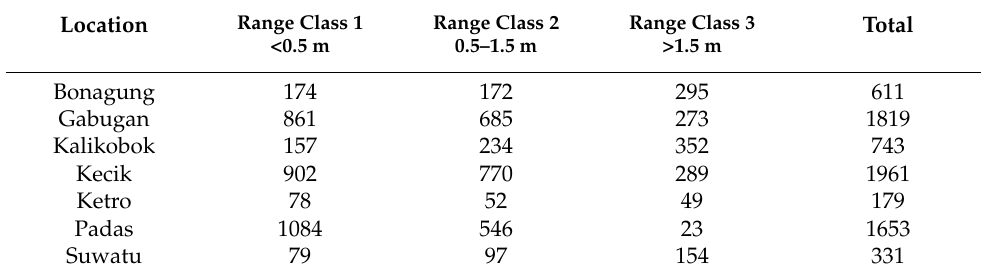
Table 6. Total number of people at risk.